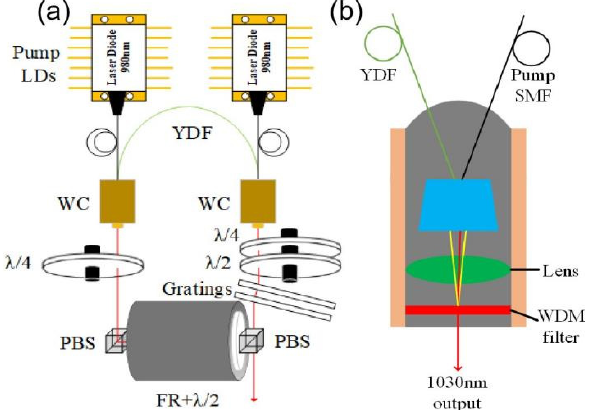
Figure 1. ( a ) Schematic configuration of the “solid-state fiber laser”. LD: 1200 mW laser diode; FR: Faraday rotator; PBS: polarization beam splitter; WC: wavelength-division-multiplexer (WDM) collimator; λ /2: Half-wave plate; λ /4: Quarter-wave plate; YDF: Yb-doped fiber. ( b ) Schematic diagram of the WDM collimator.